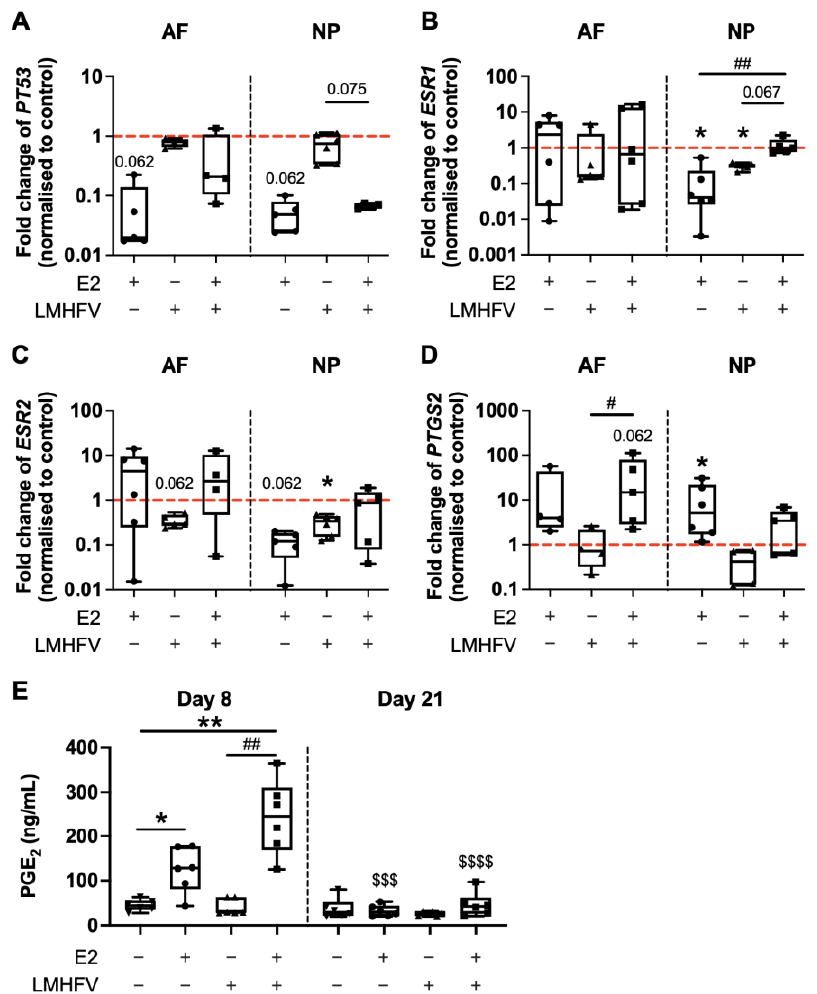
Figure 2. Relative gene expression of cell metabolism and apoptosis marker ( A ) PT53 , oestrogen receptors ( B ) ESR1 and ( C ) ESR2 , and pro-inflammatory gene ( D ) PTGS2 in cells of the AF and NP. RNA was isolated at day 8 of organ culture. IVD groups were either cultured under basal conditions (control) or treated with oestrogen (E2), low-magnitude high-frequency vibration (LMHFV) or the combination of E2 + LMHFV. Levels of mRNA were normalised to GAPDH and to the control ( red dashed line = 1). Results are presented as 2 −ΔΔCt . ( E ) PGE2 quantification (ng/mL) in culture supernatants at days 8 and 21. Box plots ( n = 4–6 IVDs/group). * p < 0.05, ** p < 0.01 (*, comparison to control); # p < 0.05, ## p < 0.01 ( # , comparison to E2 + LMHFV group); $$$ p < 0.001, $$$$ p < 0.0001 (*, comparison to the same group at day